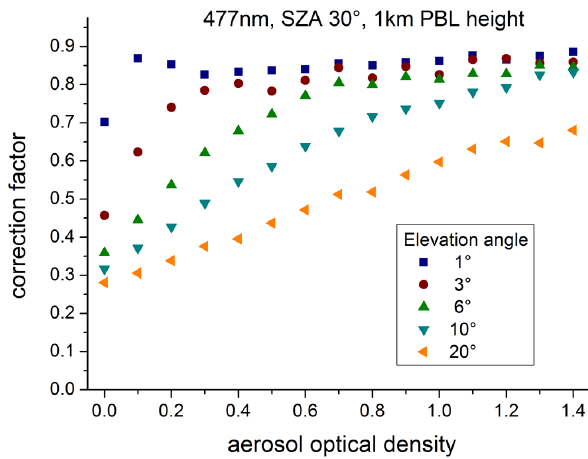
Fig. 3. Arbitrarily chosen example of calculated correction factors (for the elevation angles 1 ◦ , 3 ◦ , 6 ◦ , 10 ◦ and 20 ◦ ) versus aerosol op- tical density for 477nm, 30 ◦ SZA and 1km PBL height (homoge- neous layer for both aerosol and trace gas). With increasing aerosol load, the correction factors form a kind of plateau; the earlier the lower the elevation angle. This general behavior of the correction factors can be seen in all wavelengths, layer heights and different solar zenith angles investigated in this